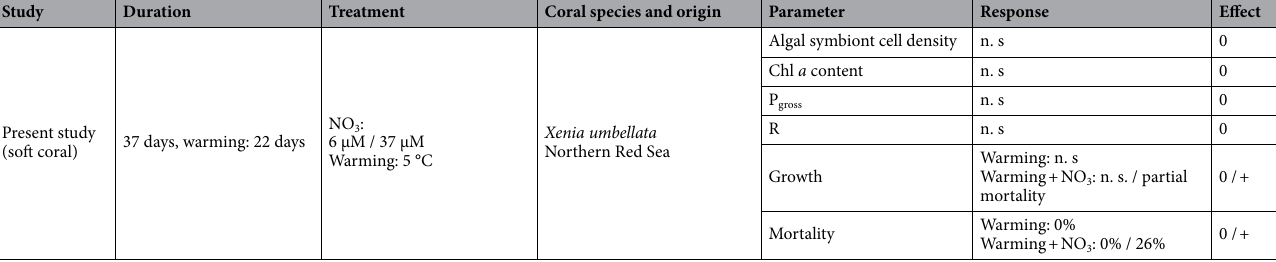
Table 2. Experimental studies on effects of combined nitrate eutrophication and warming on hard corals in comparison to the present study. Only parameters similar to the ones measured in the present study were summarized. NO 3 = Nitrate concentration, Warming = increase of temperature relative to controls, Fv/Fm = maximum quantum efficiency of Photosystem II. % values are changes relative to controls (* changes of imbalanced relative to nutrient replete conditions), n. s. = no significant difference to controls. Effect: " + " = combined warming and nitrate eutrophication result in greater reduction than warming alone; "−" = combined warming and nitrate eutrophication result in lesser reduction than warming alone; " = " = combined nitrate eutrophication and warming have similar effects to warming alone; "0" = no effects